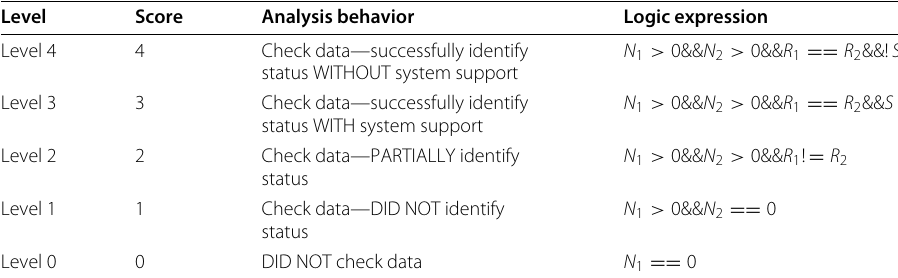
Table 2 Scoring rubric for analysis skill Level Score Analysis behavior Logic